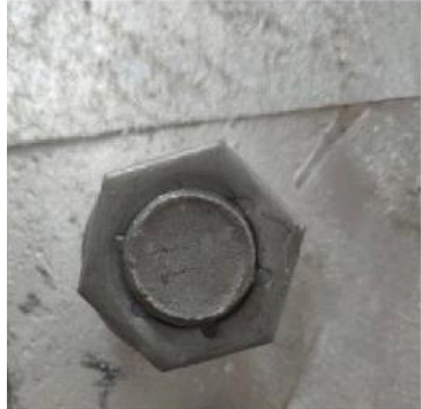
Figure 5. RGB image.